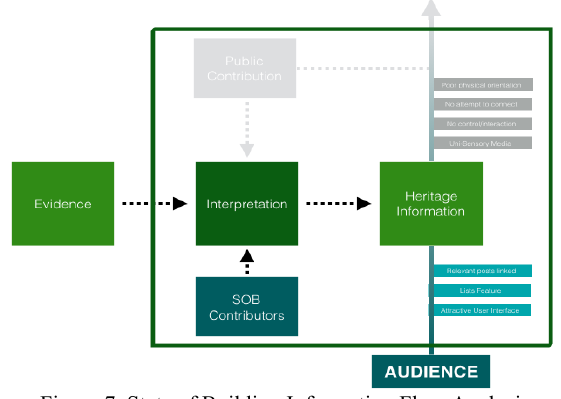
Figure 7. State of Building Information Flow